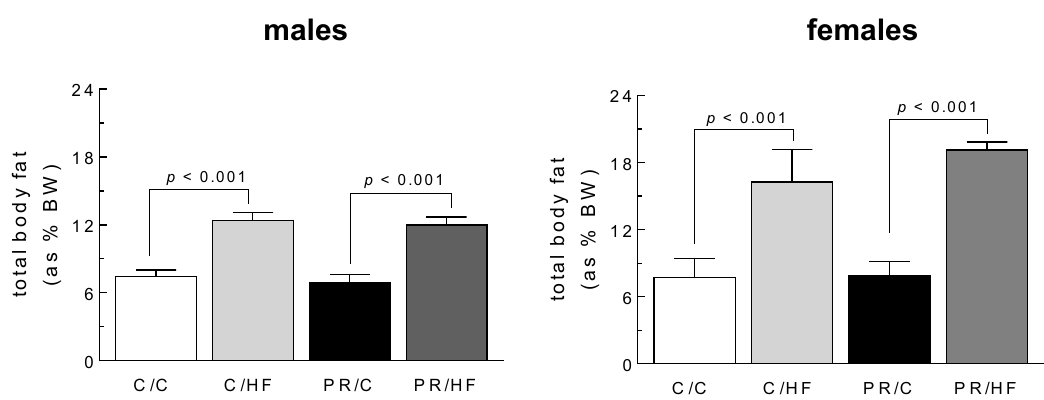
Figure 1. Total body fat (expressed as % of body weight) in male and female offspring from dams on standard chow (C) or protein restricted (PR) diet during pregnancy. Weaned offspring were then fed either a high fat (HF) or C diet to adulthood, thus generating the dam/offspring dietary group: C/C, C/HF, PR/C and PR/HF. All values are reported as means ± SME ( n = 7–11 per group) and analyzed using a one-way ANOVA with Turkey-Kramer post hoc